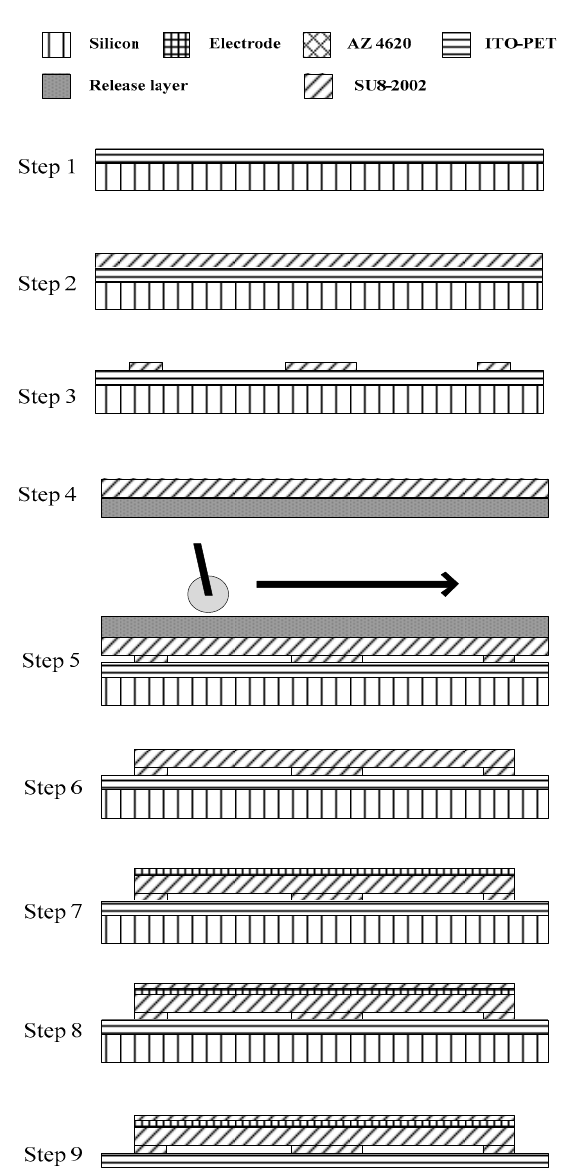
Figure 5. Transparent CMUT made by the roll-lamination fabrication technique.